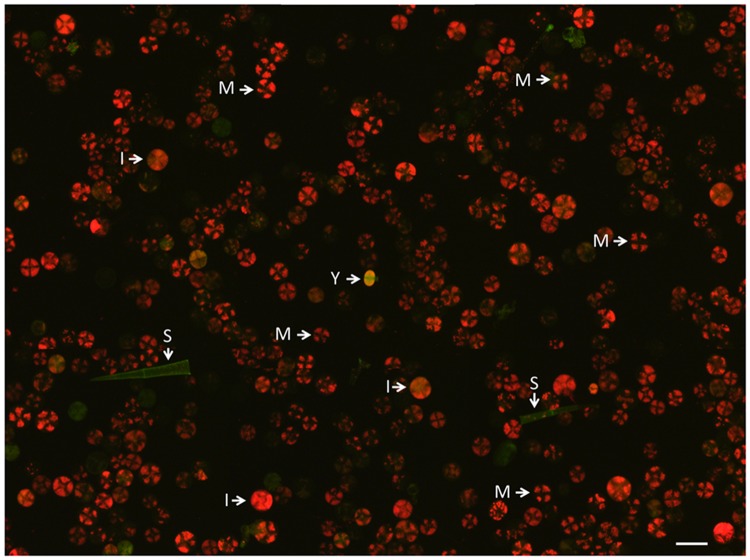
Fraction of type VI trichomes after harvest in sorbitol-buffer by the bead-beating method before sieving and cell sorting. The image was assembled from nine photographs and illustrates the low frequency of young trichomes (indicated by Y) at this stage of the preparation. The green structures are empty or possibly senescing trichomes. M, mature type VI trichomes; I, intermediate type VI trichomes; S, stalk, most likely from a type I or III trichome.